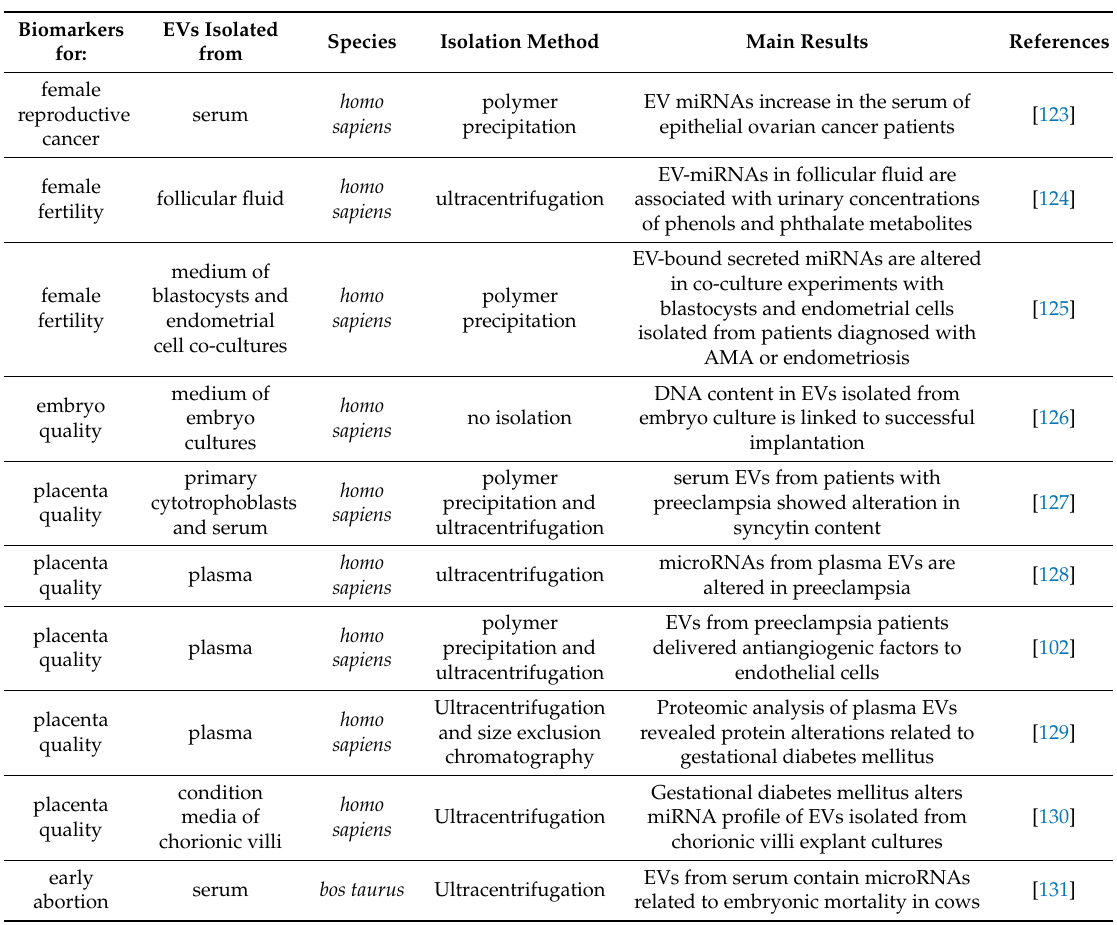
Table 3. Studies reporting the use of molecular cargos of EVs as biomarkers in reproductive medicine. Studies were categorized by di ff erent pathological conditions describing the source and method of EV isolation and the main results